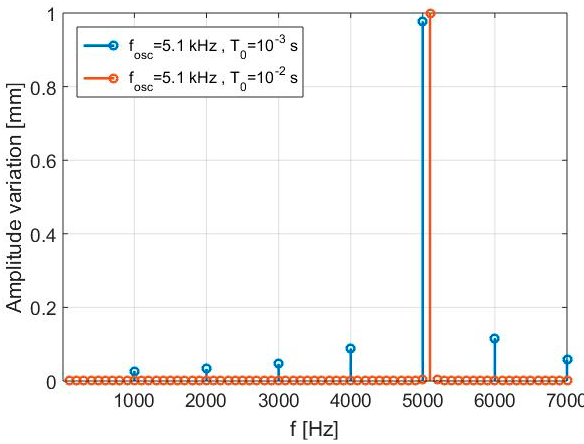
Figure 6. Third simulation—Detected displacement spectra.